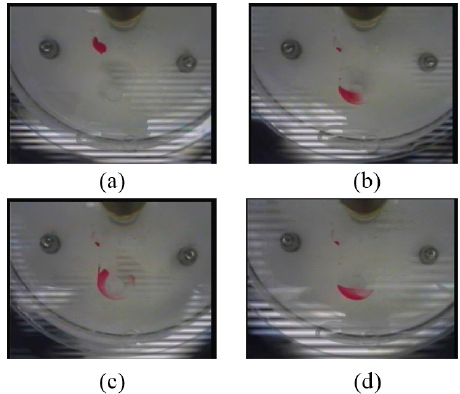
Figure 4. Photo images showing one complete cycle of mixing operation on the centrifugal microfluidic platform: ( a ) the samples were introduced into the loading chambers; ( b ) the samples were delivered to the mixing chamber; ( c ) the mixing chamber was compressed by the pin connected to the flyball governor at low mixing frequency; and ( d ) the pin was released at higher spinning speed.